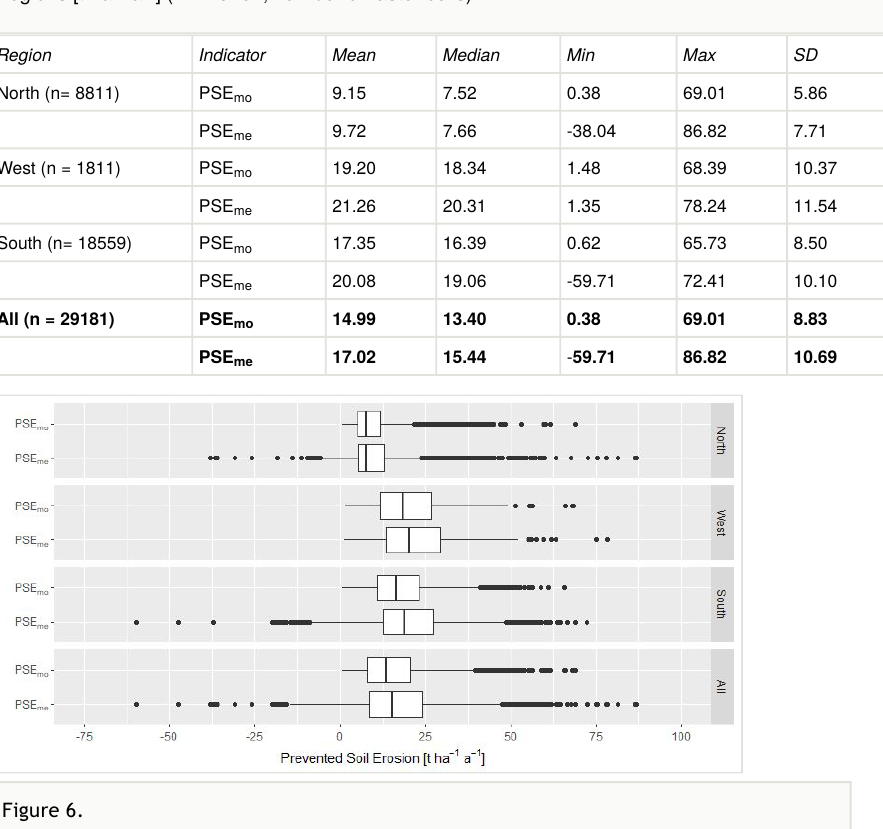
Table 6. Statistical values for the indicators describing the prevented soil erosion (PSE : based on modelled actual soil loss data, PSE : based on measured actual soil loss data), grouped by regions [t ha a ] (n = 29181, number of raster cells).